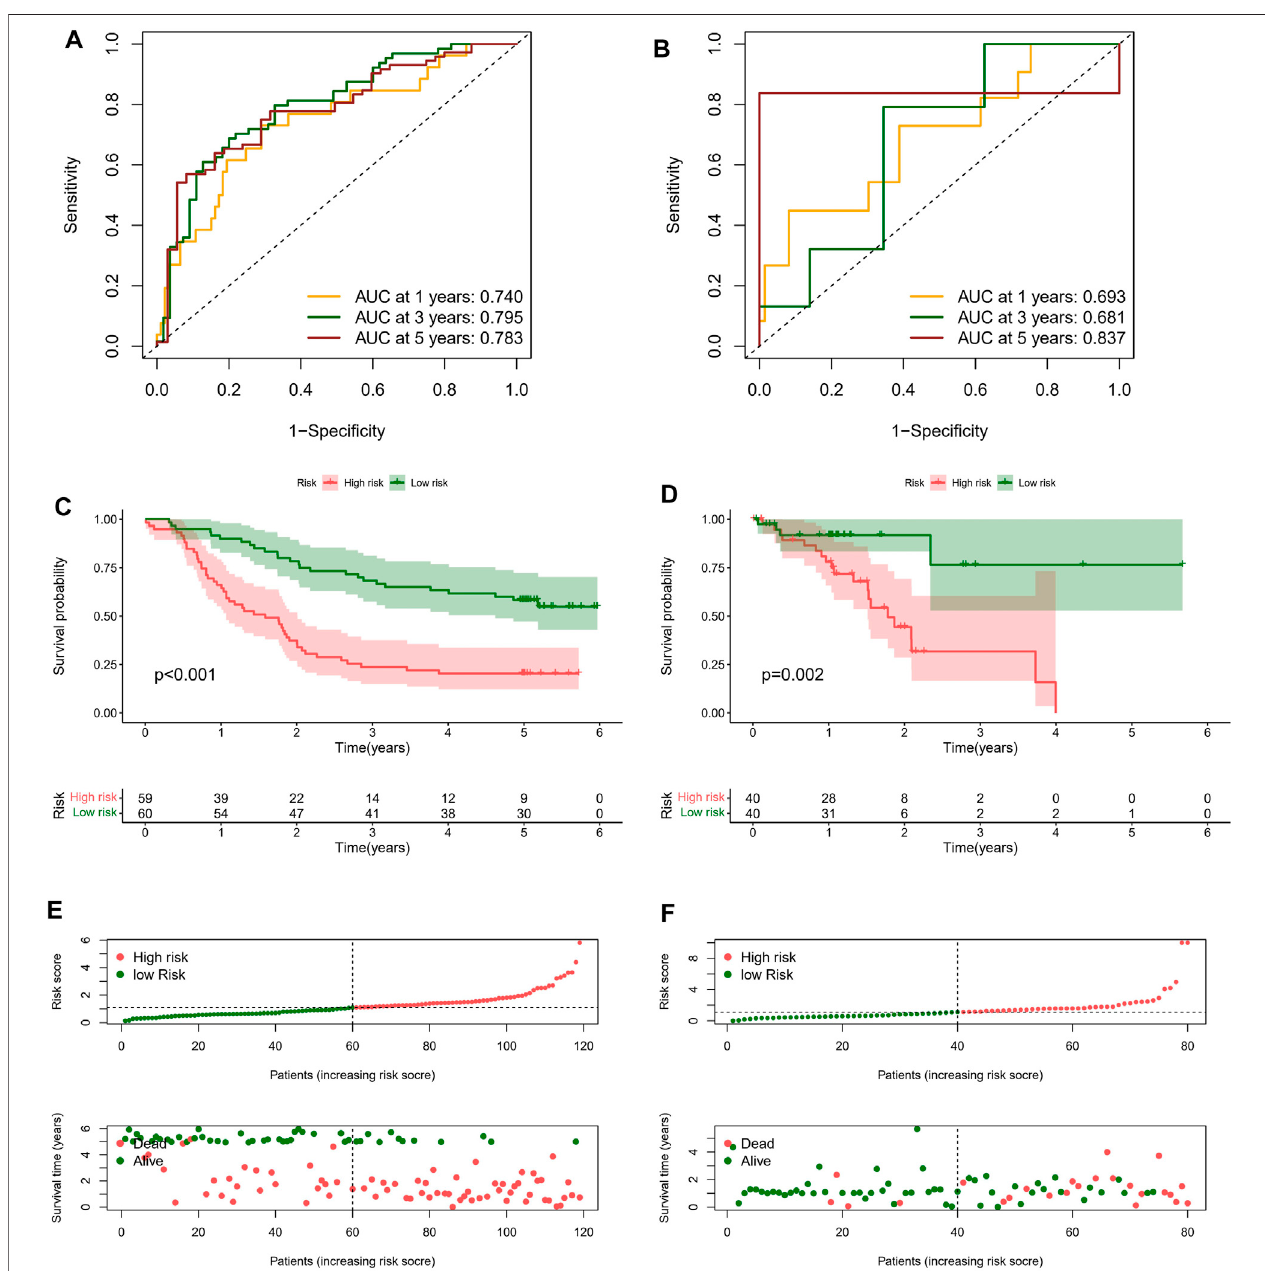
FIGURE 4 | Clinical bene fi ts of prognostic model. ROC curves and their AUC value represented 1-, 3-, and 5-years predictions in GEO (A) and TCGA cohorts (B) . Kaplan-Meier curves showed that the high-risk group had worse survival probability than the low-risk group in GEO (C) and TCGA cohorts (D) . (E,F) Risk score distribution plotshowedthe distribution ofhigh-risk and low-risk ESCC patients; Scatter plot showed thecorrelationbetweenthe survivalstatus and riskscoreofESCC patients.